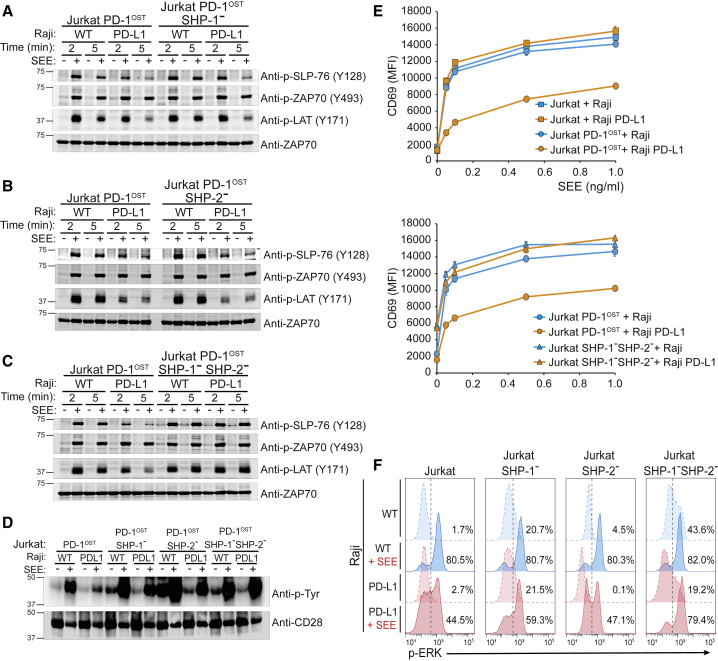
Signaling Pathways Affected by PD-1 Engagement at T Cell-APC Interface in the Presence of SHP-1 and SHP-2, Either SHP-1 or SHP-2, or Neither SHP-1 nor SHP-2Jurkat-PD-1OST, Jurkat-PD-1OST SHP-1–, Jurkat-PD-1OST SHP-2–, and Jurkat-PD-1OST SHP-1–SHP-2– cells were stimulated with Raji cells or Raji-PD-L1 cells that were preincubated in the absence (–) or presence (+) of 200 ng/mL SEE. The various T cell-B cell combinations were lysed after been kept in contact for 2 and 5 min at 37°C.(A) Immunoblot analysis of equal amounts of proteins from total lysates of Jurkat-PD-1OST cells expressing or deprived of SHP-1, probed with phospho-tyrosine-specific antibodies directed against SLP-76 pY128, ZAP-70 pY493 and LAT pY171, and with anti-ZAP-70 antibody (loading control). Data in (A) to (D) are representative of two independent experiments.(B) Immunoblot analysis of equal amounts of proteins from total lysates of Jurkat-PD-1OST cells expressing or deprived of SHP-2, probed as in (A).(C) Immunoblot analysis of equal amounts of proteins from total lysates of Jurkat-PD-1OST cells expressing or deprived of both SHP-1 and SHP-2, probed as in (A).(D) CD28 was immunoprecipitated from equal amounts of proteins from total lysates of the specified Jurkat cells and analyzed in immunoblots probed with antibody to phosphorylated proteins (Anti-p-Tyr) and with anti-CD28 antibody (loading control).(E) Jurkat-PD-1OST and Jurkat-PD-1OST SHP-1–SHP-2– cells were stimulated with either Raji cells or Raji-PD-L1 cells that were preincubated in the absence (0) or presence of the specified amounts of SEE. For each condition, CD69 upregulation was measured using fluorescence-activated cell sorting (FACS) 24 h after stimulation. Data are representative of two independent experiments, and mean and SEM are shown. MFI, mean fluorescence intensity.(F) Jurkat-PD-1OST, Jurkat-PD-1OST SHP-1–, Jurkat-PD-1OST SHP-2–, and Jurkat-PD-1OST SHP-1–SHP-2– cells were stimulated as in (E), and ERK phosphorylation was measured using FACS 5 min after contact of the specified T and B cells. Numbers indicate the percentage of phospho-ERK+ cells. Data are representative of two independent experiments.